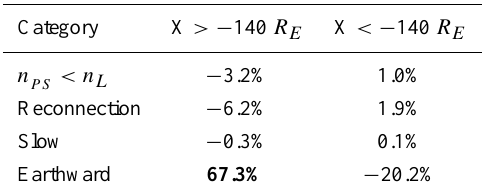
Fig. 1. (a) to (d) The average percent- age of the magnetosheath momentum required to drive the observed flows. (e) to (h) The average ratio of the min- imum predicted mass to the observed plasma sheet mass. The upper six pan- > n els contain the data where n . PS L The diamonds in Figs. 1a and 1e are the reconnection-like flows, the crosses in Figs. 1b and 1f are the slow tailward flows and the triangles in Figs. 1c and 1g are the earthward flows. The lower < panels contain the data where n PS n . The panels are ordered with re- L spect to V PS . For the slow tailward flows, of the order of 4% of magne- tosheath momentum (upper horizontal line in panels 1a–1d, the lower line is at 1%) is required to drive 40% the ob- served slow flows. However, the aver- age mass density ratio is significantly greater than 1 (horizontal line in pan- els 1e–1h). This suggests that momen- tum transfer is more likely to be the preferred alternative mechanism driv- ing slow plasma sheet flows.